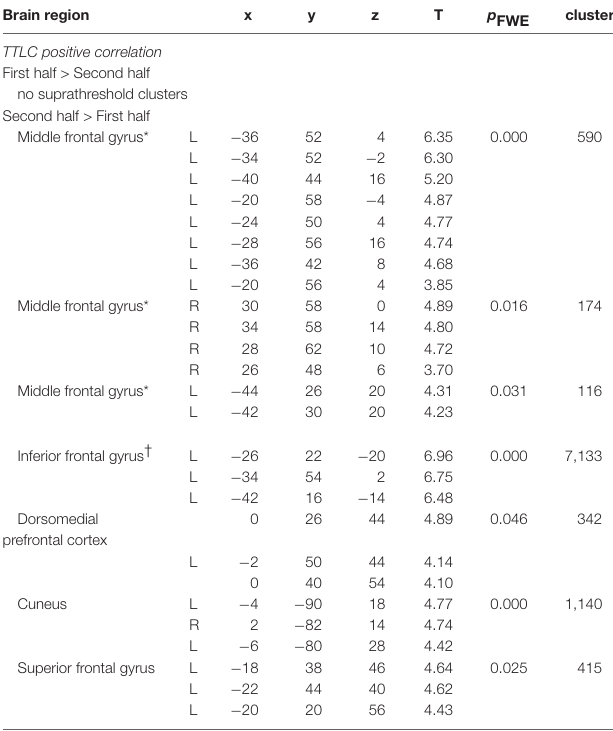
Asterisks indicate the results of SVC analysis within the frontoparietal control network. Others indicate the results of whole-brain analysis. Daggers indicate a cluster that overlaps with the frontoparietal control network ROI. x, y, and z indicate the MNI coordinates. Abbreviations: TTLC, the time to line crossing; SVC, small-volume correction; FWE, family-wise error; MNI, Montreal Neurological Institute.